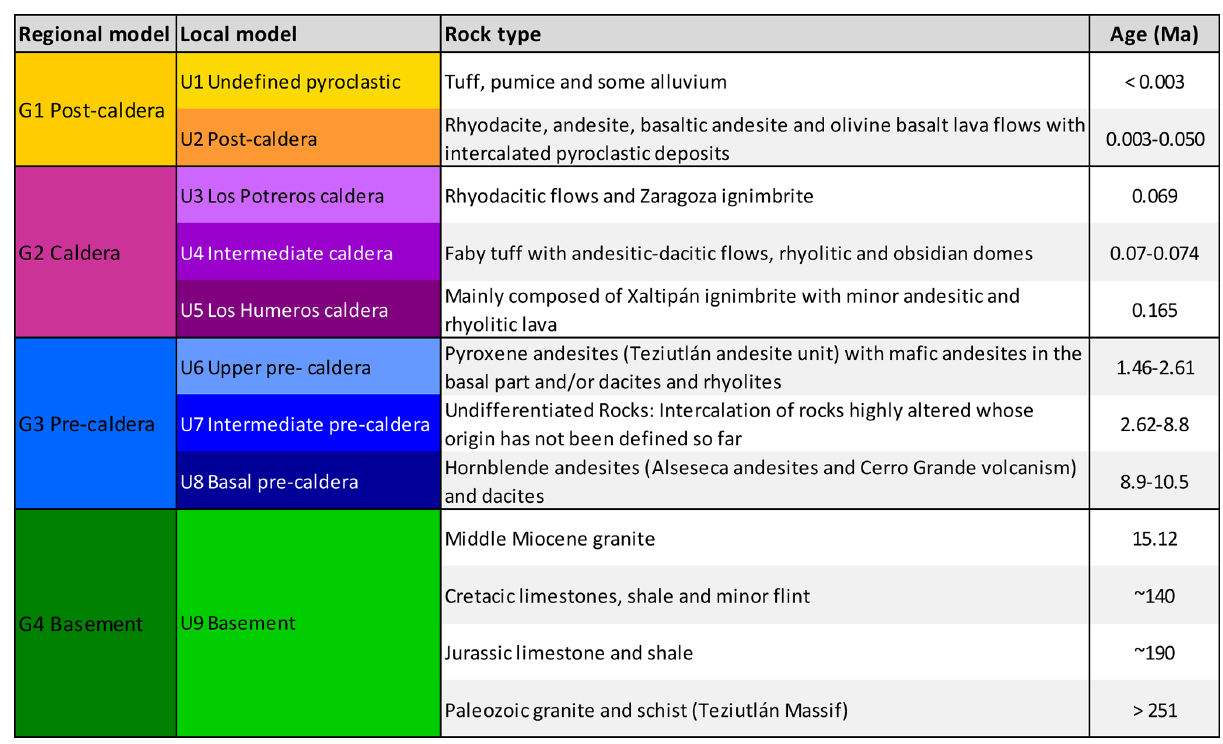
Figure 5. Regional and local model units of the 3D geological model of Los Humeros (slightly modified from Calcagno et al., 2018, 2020).